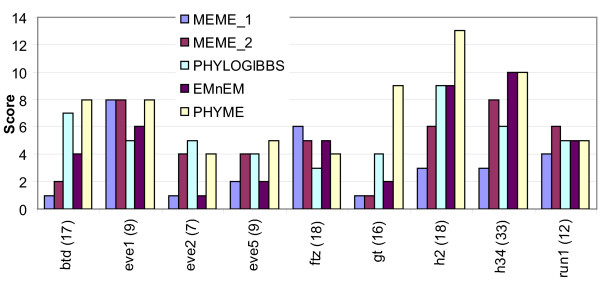
Comparison of PhyME to 1 species and 2 species MEME, and to PhyloGibbs and EMnEM, for fly enhancers. The parenthetical number next to an enhancer name is the number of strong occurrences of the known weight matrix, in the D. melanogaster sequence.